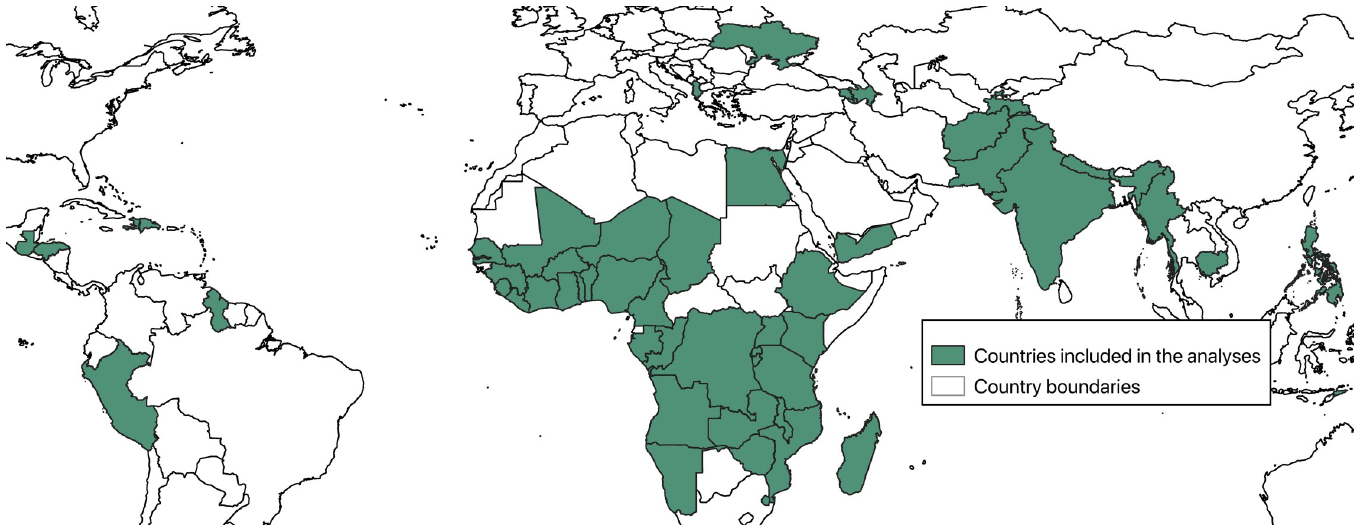
Fig 1. Map of countries that contributed at least one population-based survey to the analysis.